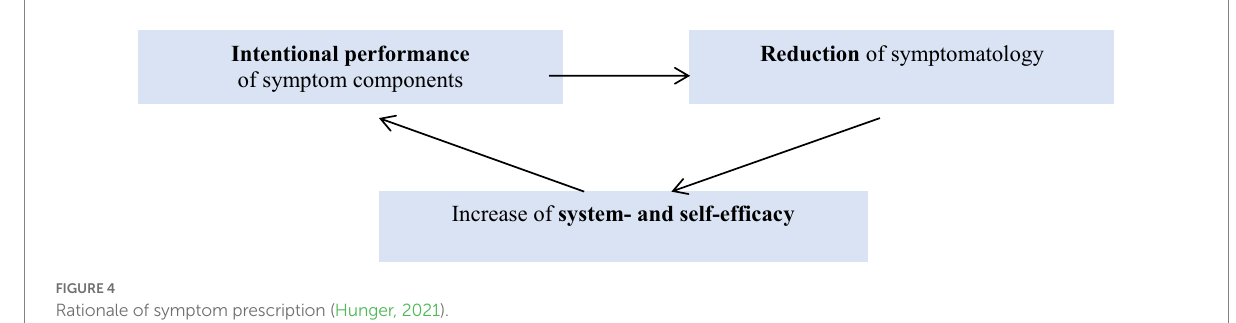
FIGURE 4 Rationale of symptom prescription (Hunger,